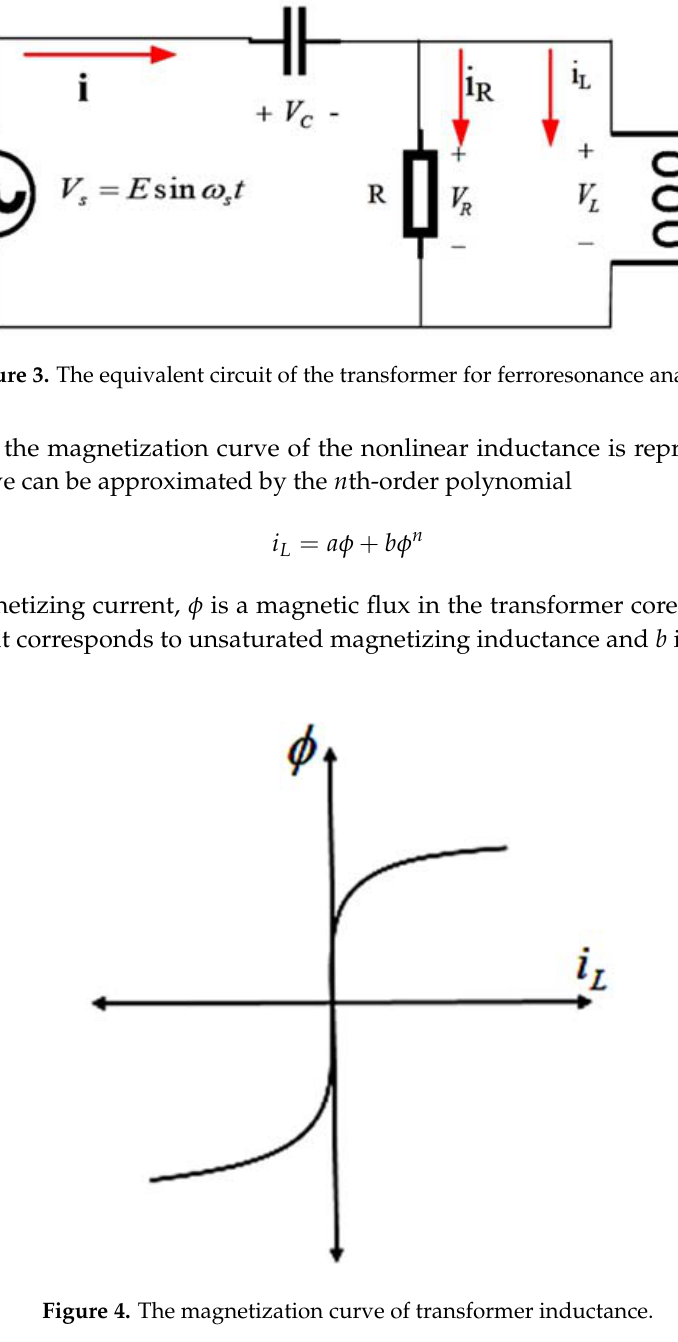
Figure 4. The magnetization curve of transformer inductance.